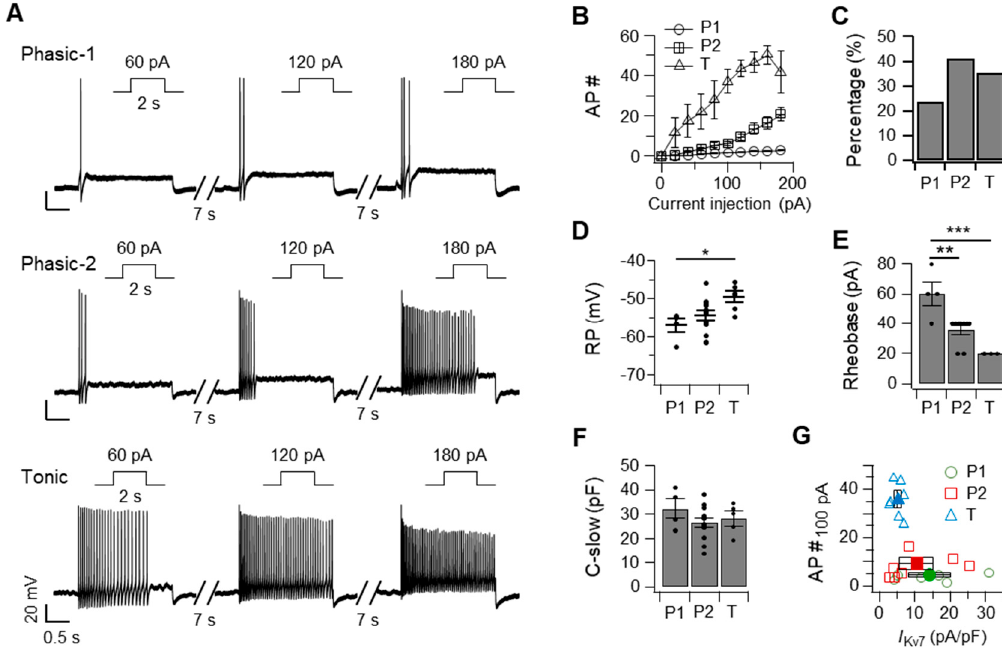
Figure 1. Superior cervical ganglia (SCG) neurons can be classified as phasic-1, phasic-2, and tonic cells, based on their firing pattern, resting membrane potential, and Kv7 current density. Representative traces showing discharges ( A ) and the average number ( B ) of action potentials elicited by an injection of the indicated current for 2 s in phasic-1, phasic-2, and tonic neurons. ( C ) Percentage of recorded neurons classified as the indicated cell types. The resting membrane potential (RP, D ), rheobase ( E ), and C-slow ( F ) of each cell type. ( G ) Relationship between the density of Kv7 currents and the number of action potentials triggered by an injection of 100 pA into phasic-1 (circles), phasic-2 (squares), and tonic (triangles) neurons (P1, n = 6; P2, n = 7; T, n = 7). Black symbols indicate the average. Data are mean ± SEM. One-way analysis of variance followed by Sidak’s posthoc test, * p < 0.05, ** p < 0.01, *** p < 0.001.